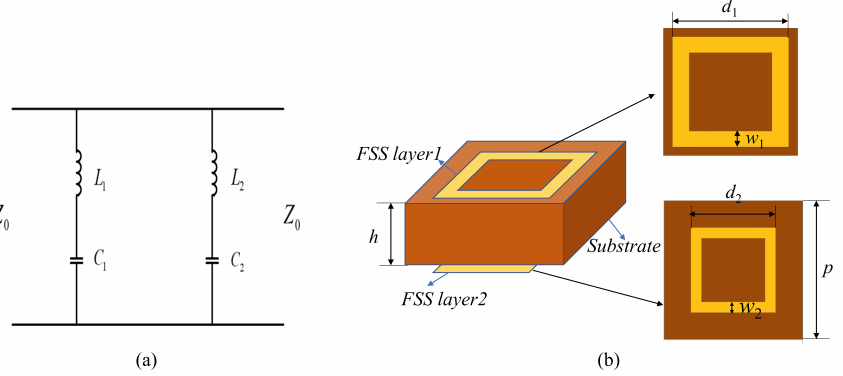
Figure 3. ( a ) The EC of the dual band-stop FSS. ( b ) Schematic diagram of the dual band-stop FSS.